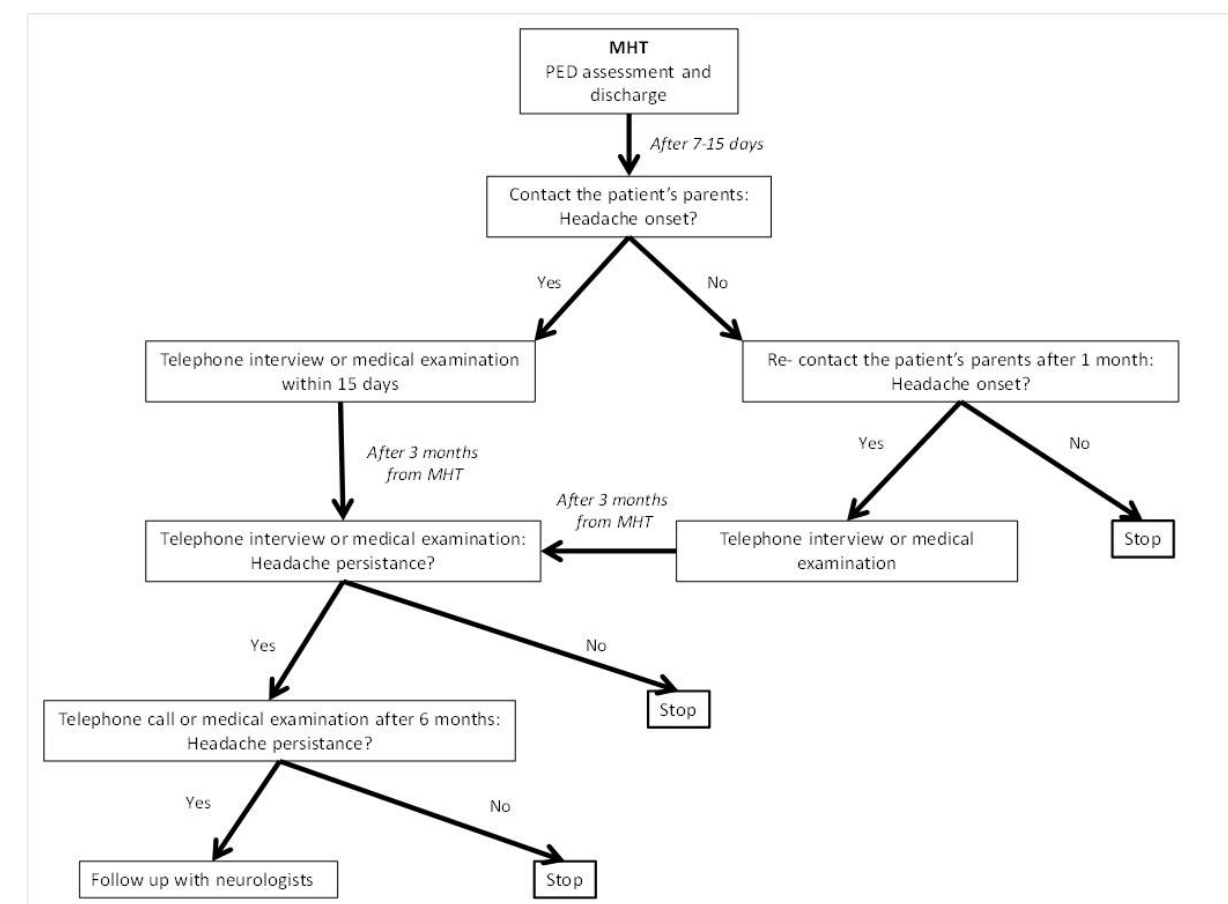
Figure 1. Operational flow-chart of the study.